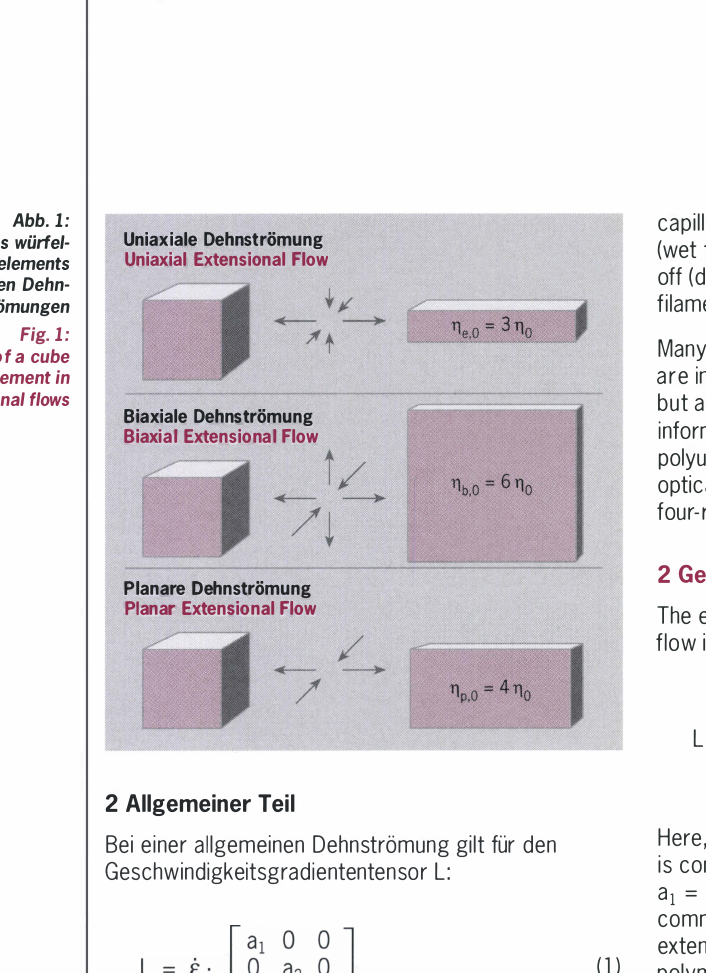
Uniaxiale Dehnstromung Uniaxial Extensional Flow